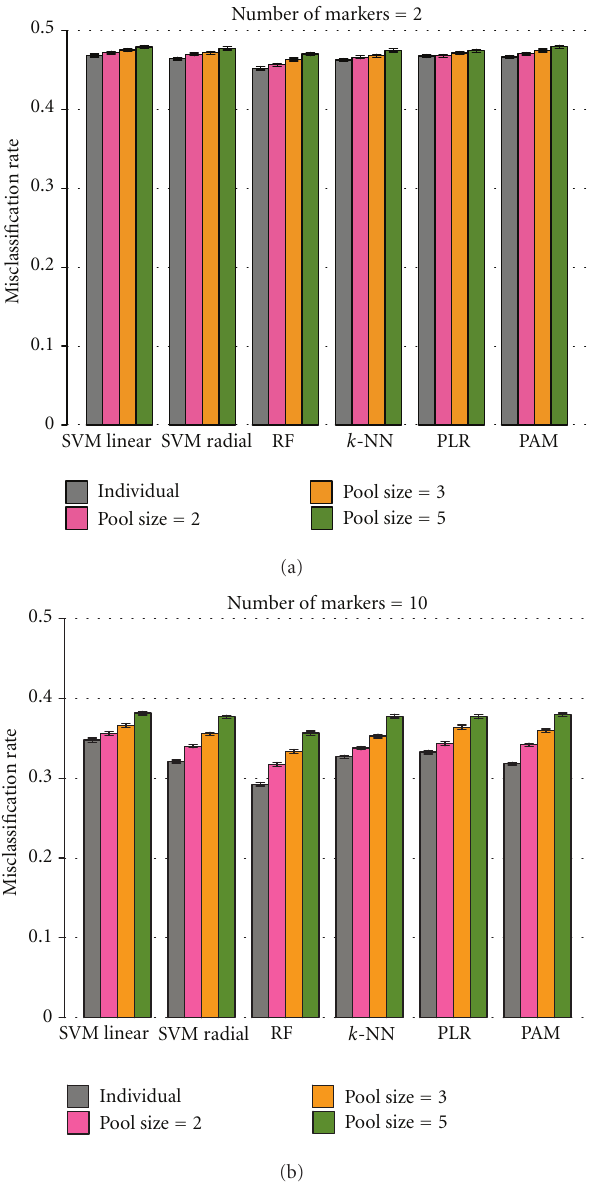
Figure 1: Performance of classifiers on individual samples and various pool sizes. A comparison of classifiers performances for datasets of individual samples and pool sizes of 2, 3, and 5 are shown. Misclassification rates rise with larger pool sizes. (a) and (b) show the comparison when numbers of markers are 2 and 10, res- pectively. The height of bars indicates 95% confidence interval from 300